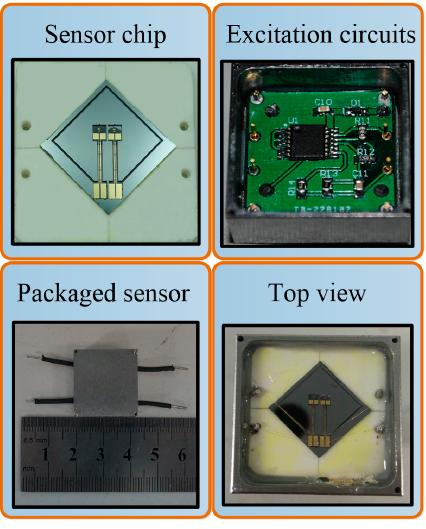
Figure 16. The prototype of packaged sensor.